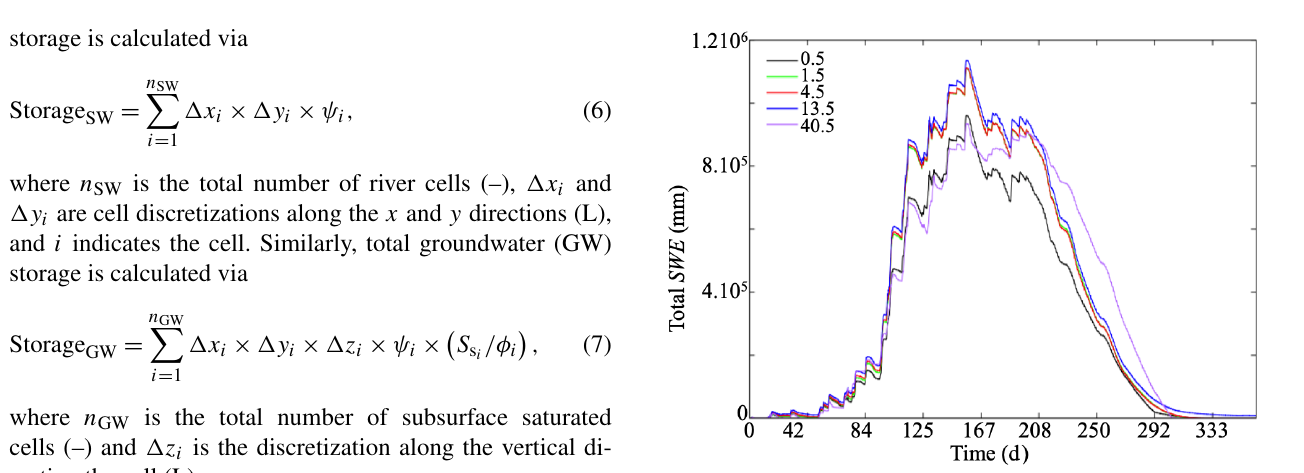
Figure 3. Temporal variations of the total snow water equiva- lent (SWE) obtained with meteorological forcing at spatial reso- lutions of 0.5, 1.5, 4.5, 13.5, and